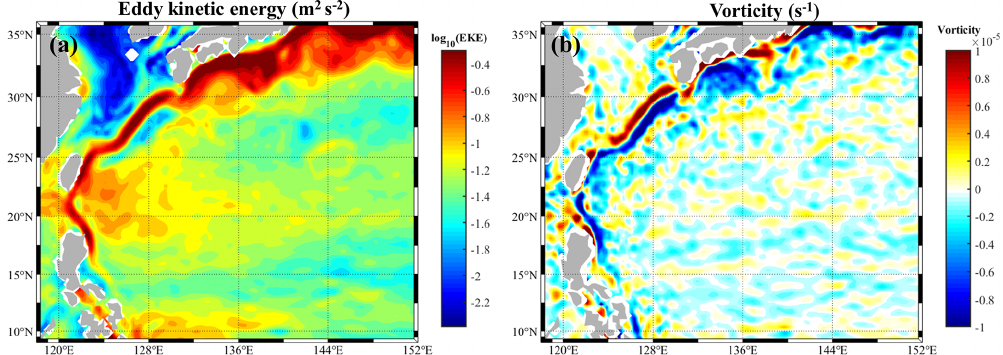
Figure 2. Maps of (a) log-scale, long-term averaged EKE and (b) long-term averaged